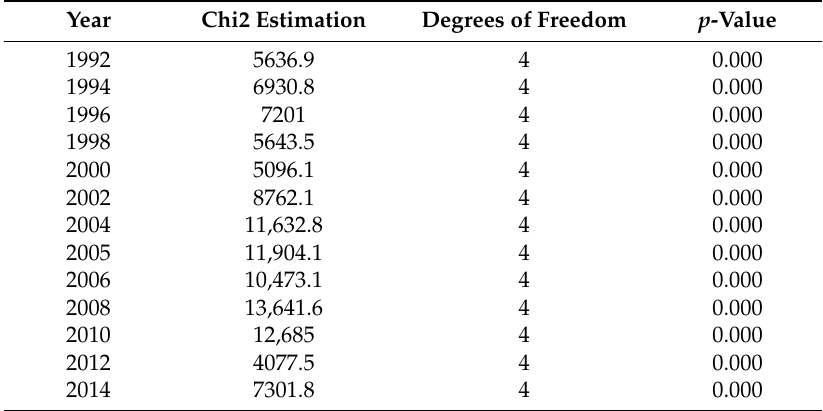
Table A2. Results of Kruskal-Wallis equality-of-populations rank test for the number of appliances and consumer’ practices latent classes.